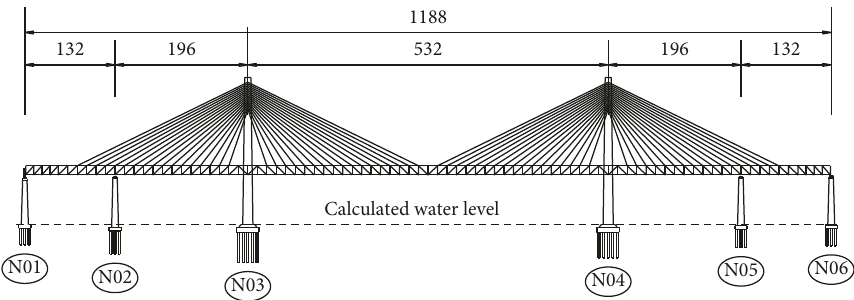
Figure 1: Layout of the target bridge (unit: